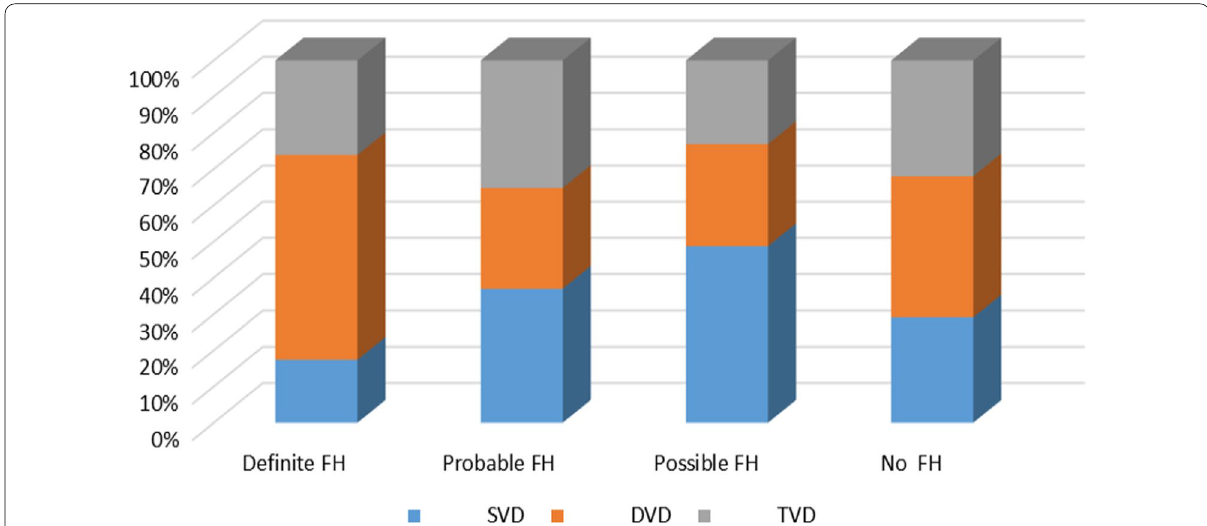
Fig. 4 Multi-colored bar diagram showing more occurrences of DVD in definite FH and TVD in probable FH patients, while patients with no FH had an almost equal probability of developing SVD, DVD, and